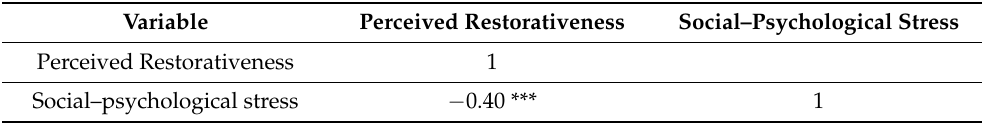
Table 4. Correlation analysis between the perceived restorativeness and social · psychological stress variables.